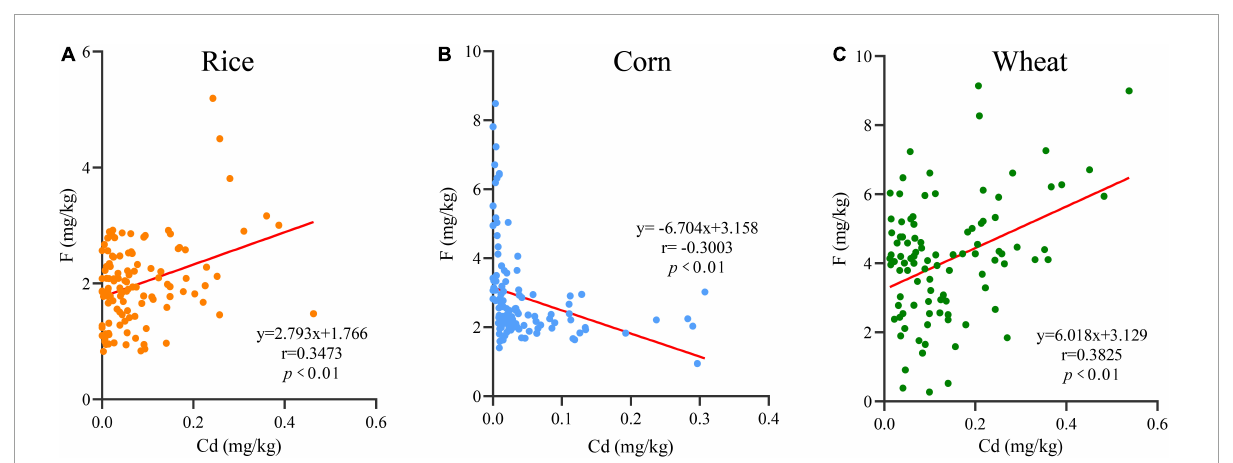
wheat had a synergistic interaction ( p < 0.01), which emerged as an antagonistic interaction ( p < 0.01) in